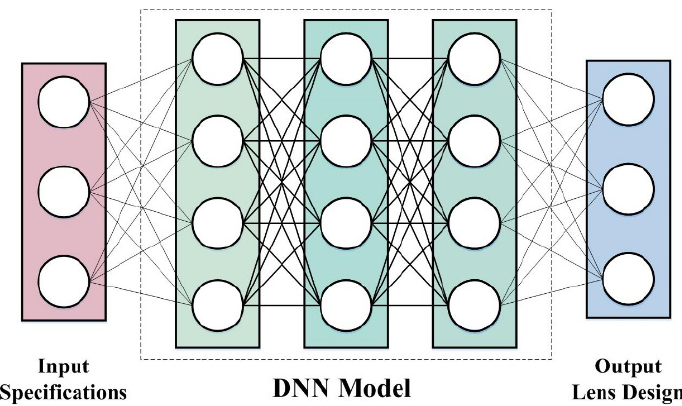
Figure 2. Framework with the training process for the lens design.